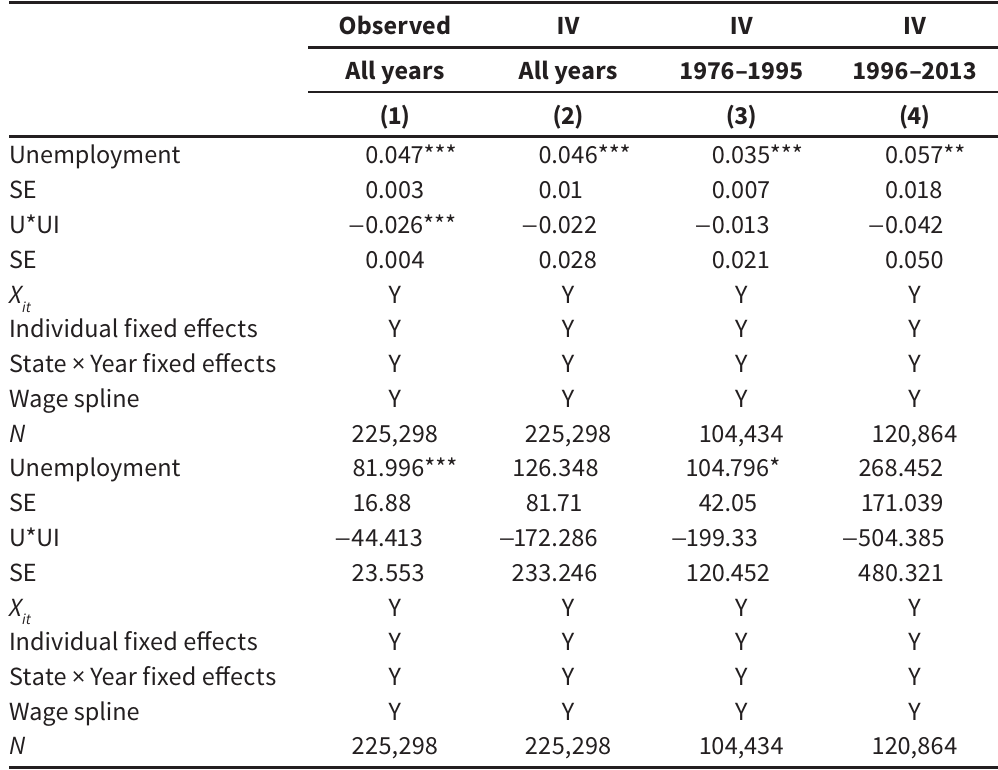
Coefficient estimates of regressions of family transfer receipt on